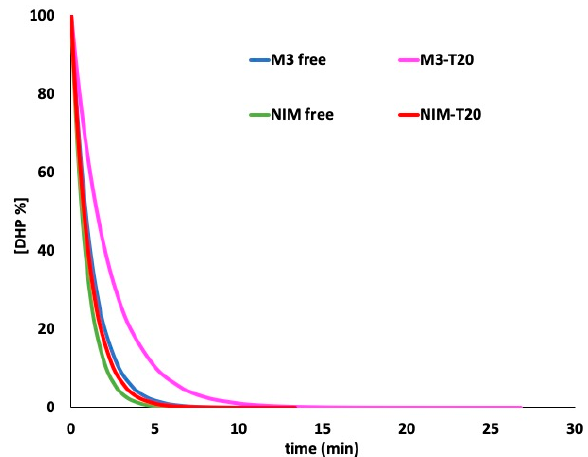
Figure 5. Photodegradation of M3 and NIM in ethanol and surfactant solutions.